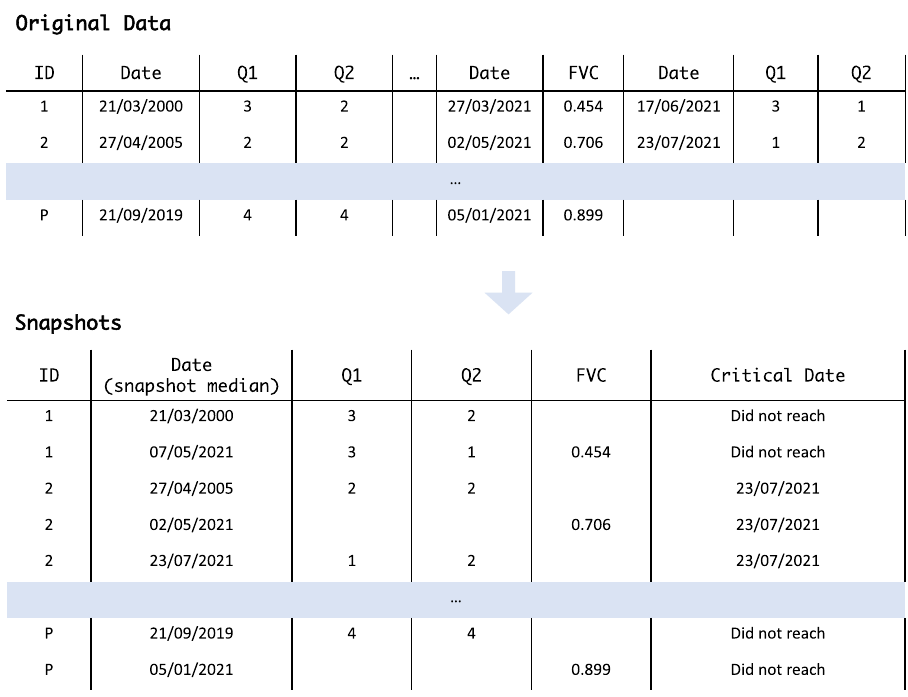
Figure 6. An example of the transformation of the original data into patient snapshots following Carreiro et al. approach 12 . Patient 2 is the only individual who reached a C2 critical status (Q1 ≤ 1), with the corresponding date being identified in its snapshots. Other critical dates based on tests are further computed based on well- established clinical